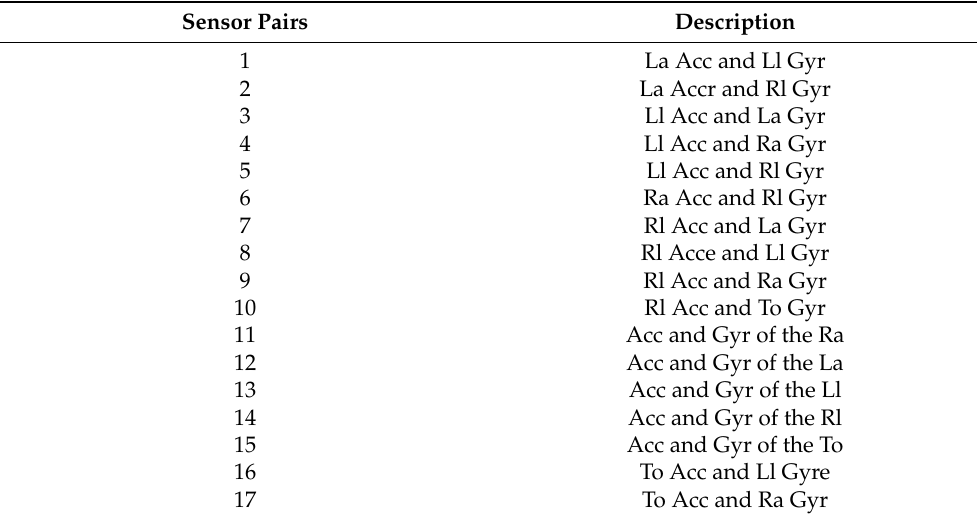
Table 4. Sensor used to extract the DSA data sets. To = Torso, Ra = Right arm, La = Left arm, Rl = Right leg, and Ll = Left